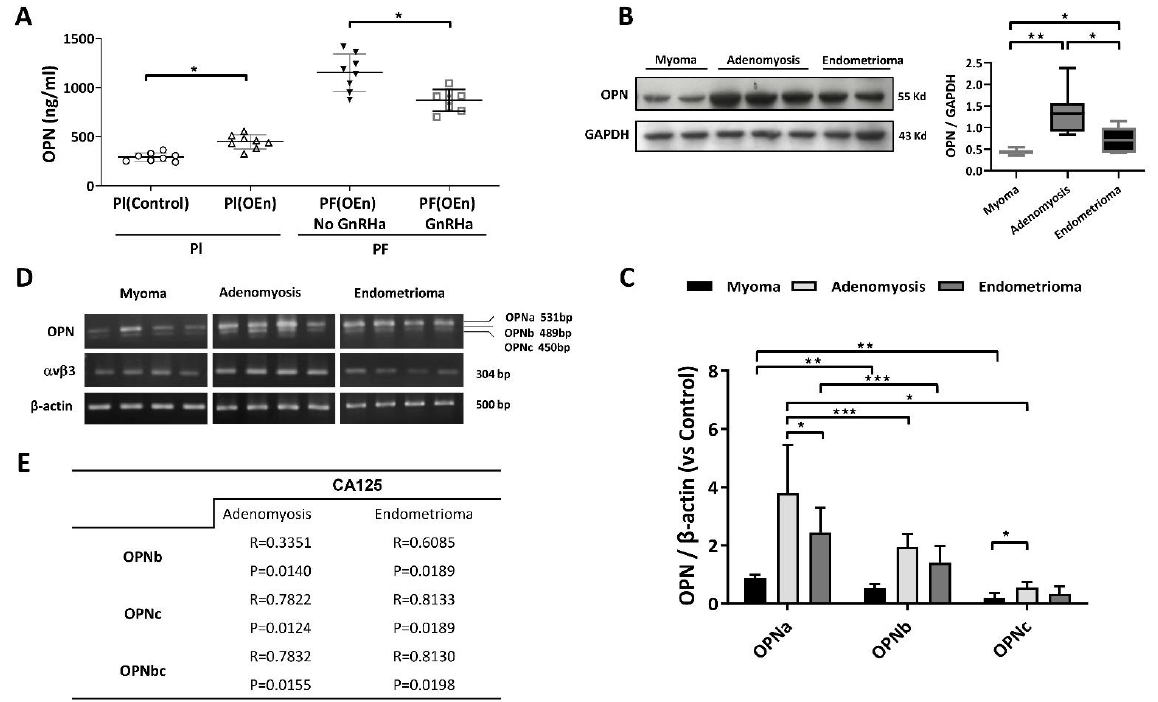
Figure 1. Expression of OPN and OPN isoforms in endometriotic lesions. ( A ) OPN levels in plasmas from women with myomas (n = 8, control) and women with ovarian endometrioma (n = 8), in peritoneal fluids from women with ovarian endometrioma (n = 8) before and after GnRH agonist treatment. ( B ) Representative blot image and quantitative analysis of Western blot data on OPN in myoma (n = 12), adenomyosis (n = 12), and ovarian endometrioma tissues (n = 12). The normalized OPN expression in adenomyosis was the highest, followed by the endometriosis tissues compared to the myoma tissues, p < 0.05. ( C , D ) Expressions of OPN isoforms (OPNa, OPNb, OPNc) in myoma, adenomyosis, and ovarian endometriosis tissues. All OPN isoforms were upregulated in endometriotic lesions, especially in adenomyotic tissue ( p < 0.05). All OPN isoforms were expressed at significantly higher levels in endometriotic lesions than in the myoma control group ( p < 0.05). ( E ) Linear correlation between CA125 and OPN isoforms in different endometriotic lesions. Plots represent the mean ± standard error of the mean (SEM). Pl: plasma; OEn: Ovarian endometrioma(s); PF: peritoneal fluid; GnRHa: gonadotropin-releasing hormone agonist; OPN: osteopontin; CA125: cancer antigen 125. (*) indicates a significant difference with p < 0.05. (**) indicates a significant difference with p < 0.01. (***) indicates a significant difference with p <